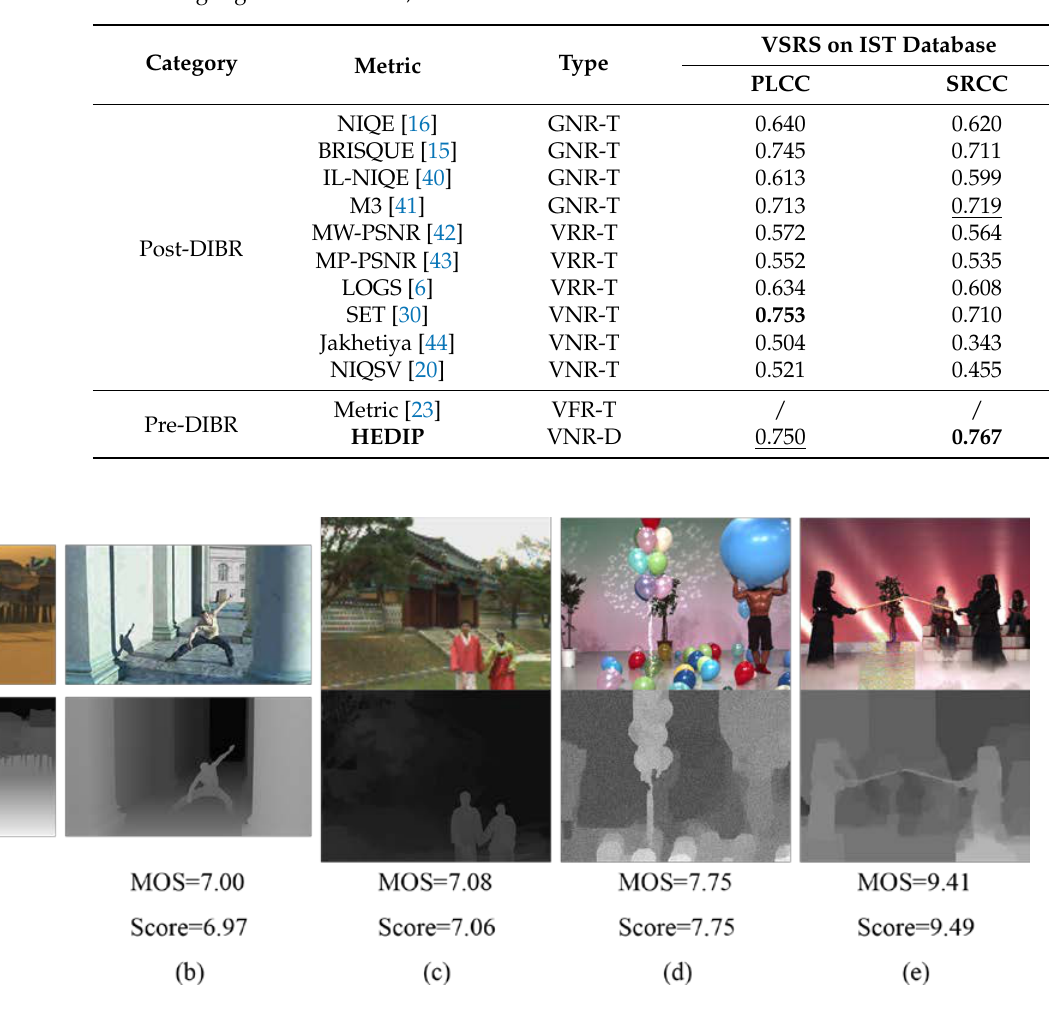
Figure 6. Texture–depth image pairs for six different scenes; the top row shows the texture image, and the bottom row shows the depth image. Each image pair comes with the MOS value and the predicted score. ( a – e ) are different scenarios. predicted score. ( a – e ) are different